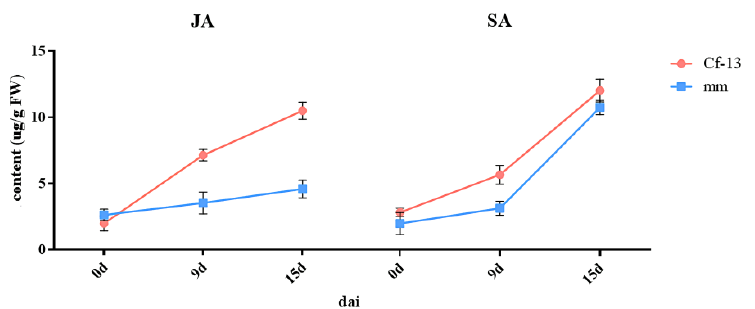
Figure 10. Fluctuations in JA and SA as a function of days after inoculation in Cf-13 plants and MM plants. JA: jasmonic acid; SA: salicylic acid; Cf-13 : Ont7813; MM: Moneymaker; dai: days after in-